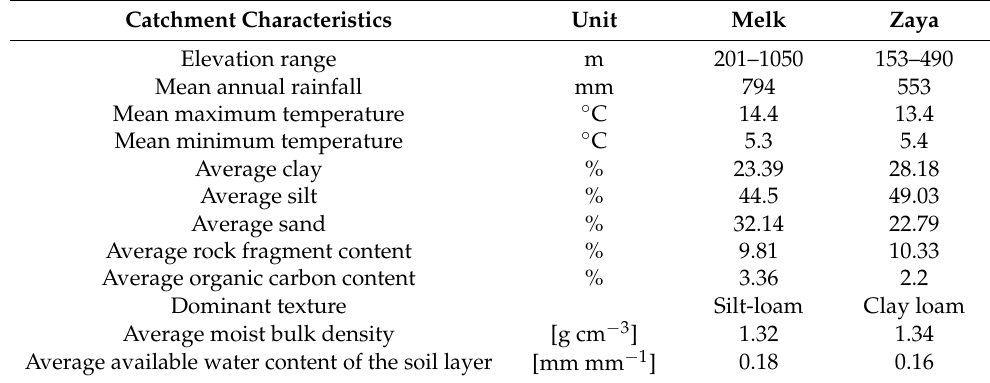
Figure 1. The land use maps with crop categories according to SWAT and river distribution in the Melk and Zaya catchments. Matzleinsdorf and Niederabsdorf are the outlet gauges of the Melk catchment and the Zaya catchment, respectively. Pötting, Hirschstetten and Marchfeld are regions where we have measured N 2 O data and simulated N 2 O data (from the DNDC model), respectively. Table 1. Characteristics of the Melk and Zaya catchments. The soil information is the average value of all soil classes in the first layer (0–300 mm) of the two catchments collected from SoilGrids (https://soilgrids.org) (accessed on 8 August 2018). Daily air temperature, precipitation and other weather data was obtained from ZAMG (https://www.zamg.ac.at/cms/de/aktuell) (accessed on 19 December 2018) and eHYD (https://ehyd.gv.at/) (accessed on 6 August 2018). The resolution of dominant texture is 250 m × 250